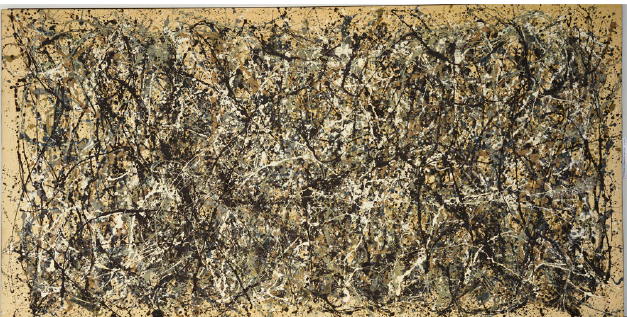
Figure 4. Jackson Pollock, One: Number 31 , 1950 , 1950, oil and enamel on canvas, 106 × 209 in. (269.5 × 530.8 cm). The Museum of Modern Art, New York. Sidney and Harriet Janis Collection Fund (by exchange). © 2022 The Pollock-Krasner Foundation/Artists Rights Society (ARS), New York.